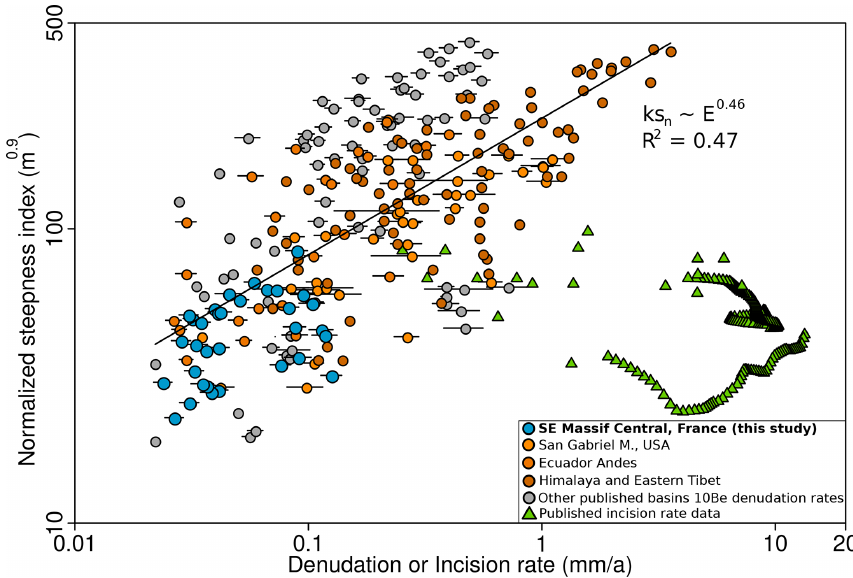
Figure 9. Comparison between our results and other published datasets for normalized channel steepness index ( θ ref = 0 . 45) and basin-wide denudation rate calculated from 10 Be concentrations. Incision rates calculated from terraces in different climatic and tectonic contexts are also plotted (green triangles). The black solid line is a power-law fit to the aggregated basin-wide denudation rate dataset. Original data for the Ecuadorian Andes are from Vanacker et al. (2015) as reported in Campforts et al. (2020). Original data for the San Gabriel Mountains are from DiBiase et al. (2010) as reported in DiBiase and Whipple (2011). Original data for the Himalayas and eastern Tibet are from Scherler et al. (2014), Wobus et al. (2005), Godard et al. (2010, 2012, 2014), Finnegan et al. (2008), Ouimet et al. (2009), and Harkins et al. (2007), as compiled by Scherler et al. (2017). Additional denudation data from Cyr et al. (2010) are also plotted, as are incision rate data from Lavé and Avouac (2000, 2001), Kirby and Whipple (2001), and Yanites et al.